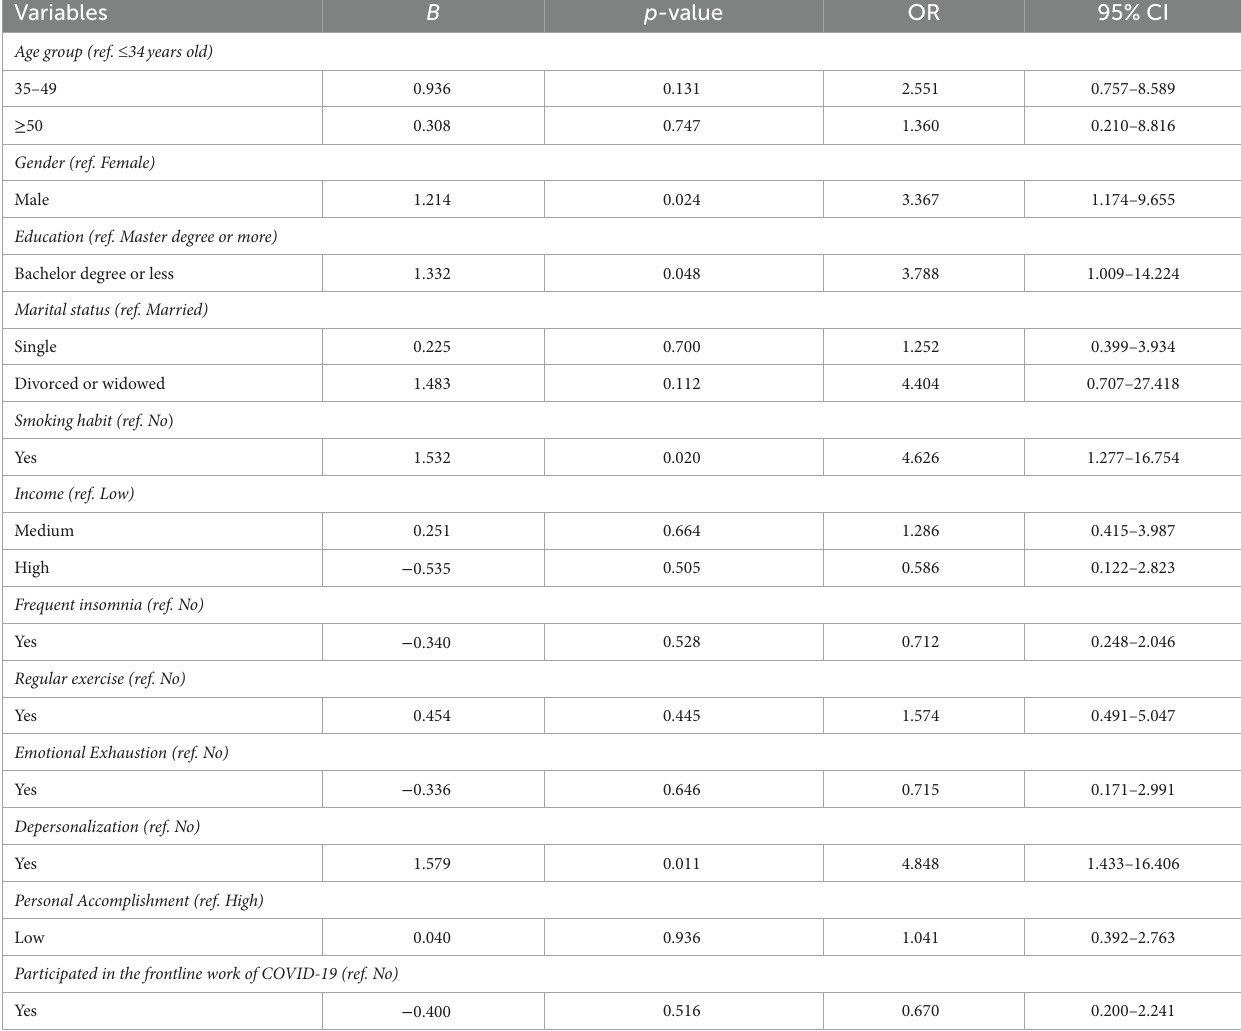
TABLE 3 Multiple logistic regression examining individual characteristics associated with alcohol misuse in Chinese clinical